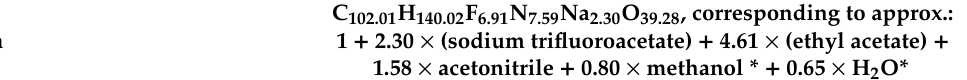
Table 3. Data collection and structure refinement for 1 + Na_triFlAc